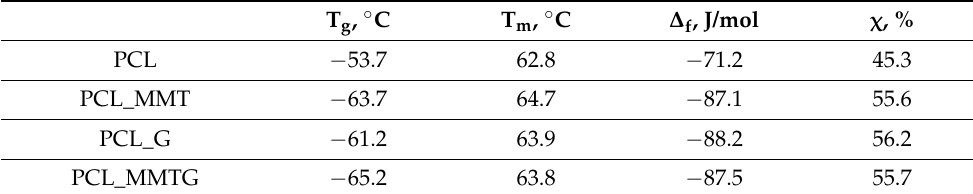
Table 5. Summary of DSC results for the tested PCL fibrous material and PCL-based nanobiocom- posites.